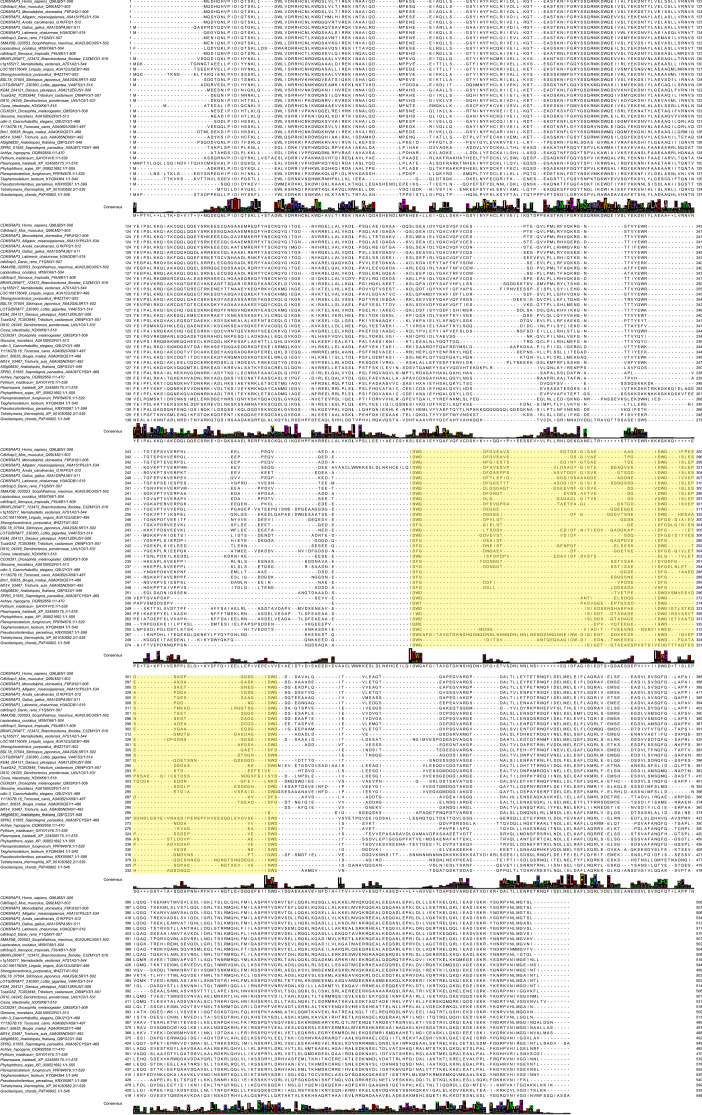
Multiple sequence alignment of C53 homologs.Protein sequences of C53 homologs from selected multicellular eukaryotic species were aligned using Clustal Omega server (Madeira et al., 2019) and processed with Jalview. Residue numbers are labeled according to the HsC53 sequence. The multiple sequence alignment used in Figure 4C is highlighted in yellow.